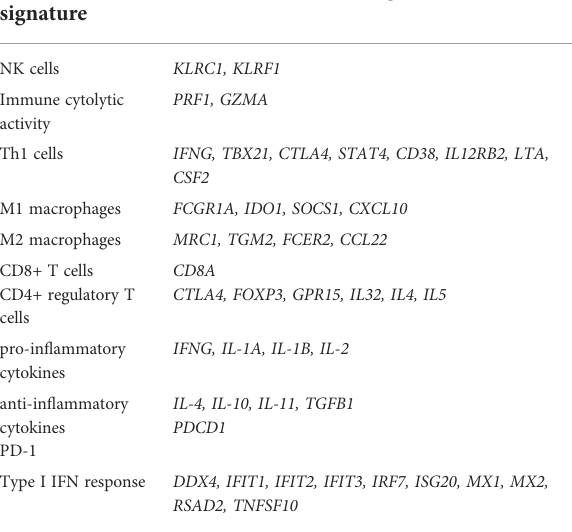
TABLE 2 Immune signatures and their marker genes.